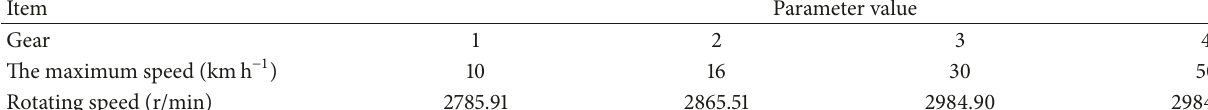
Table 7: The maximum speed of each gear.